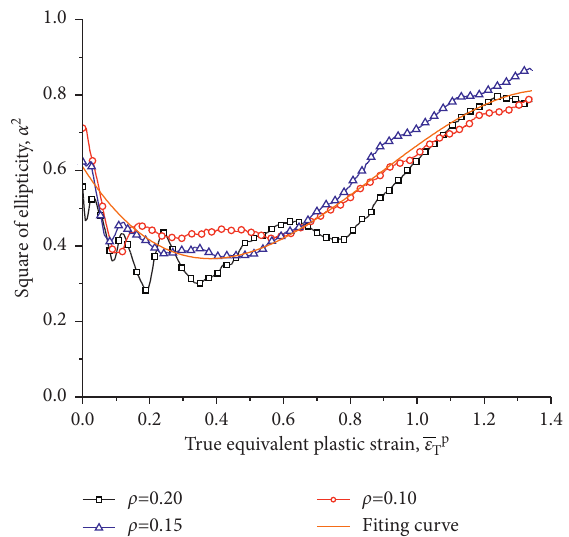
Figure 13: The relationship between ellipticity and the true equivalent plastic